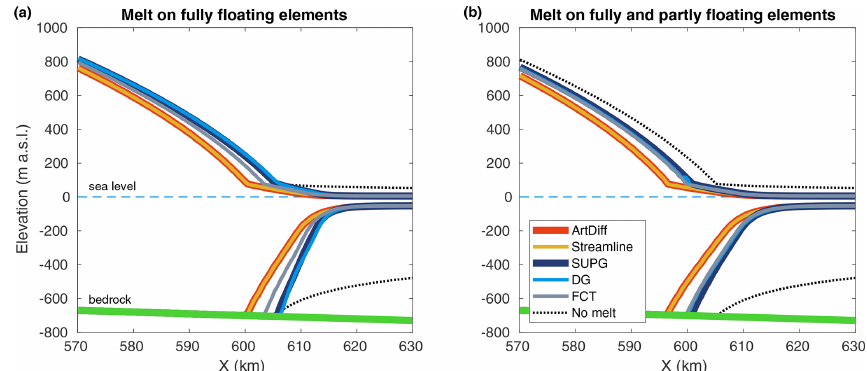
Figure 9. Basal melt experiment: ice surface and ice base at the end of the experiment ( t = 100 years) for different stabilization schemes (see legend). (a) No melt on partly floating elements. (b) Melt on fully and partly floating elements. The dotted black line is the profile obtained with no basal melt applied (no external forcing experiment; Sect. 5.2.1 and Fig. 4). Here, the set of parameterizations is SEP1 + NSED, and the mesh resolution is equal to 500m.